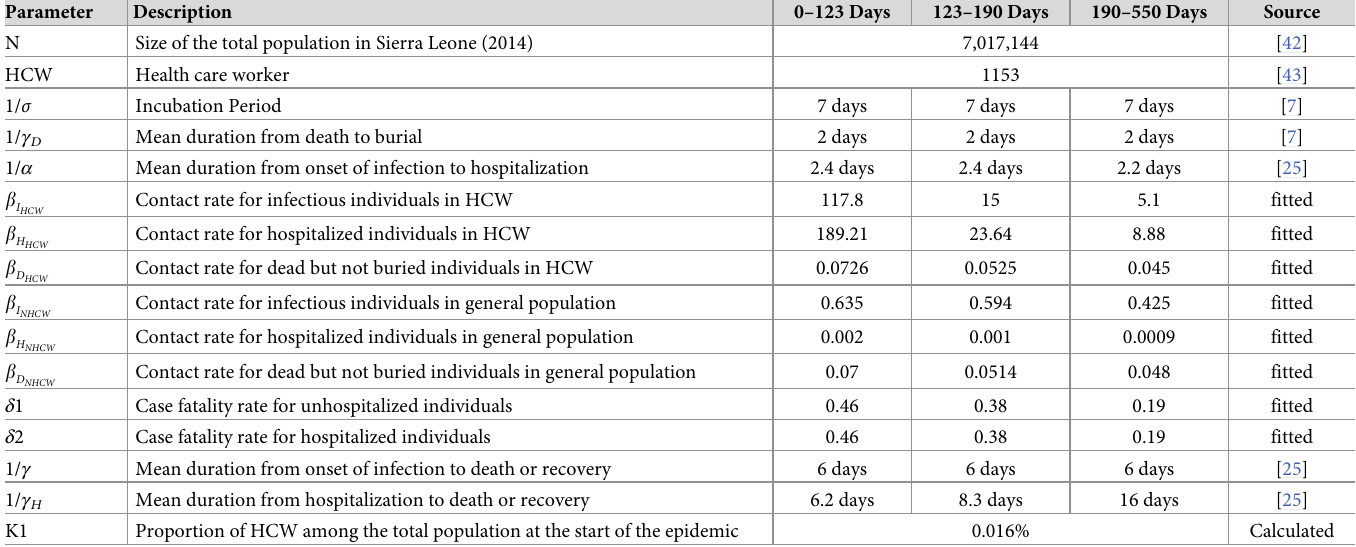
Table 1. Parameters for the hybrid